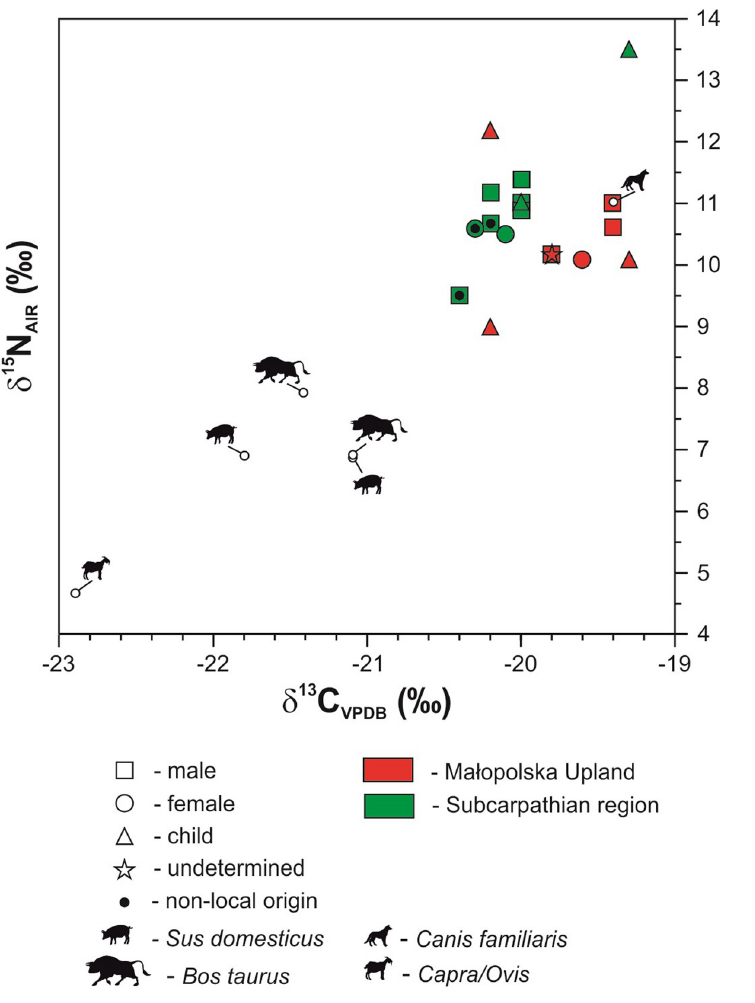
Fig 6. Plot of δ 13 C coll and δ 15 N coll values for humans and